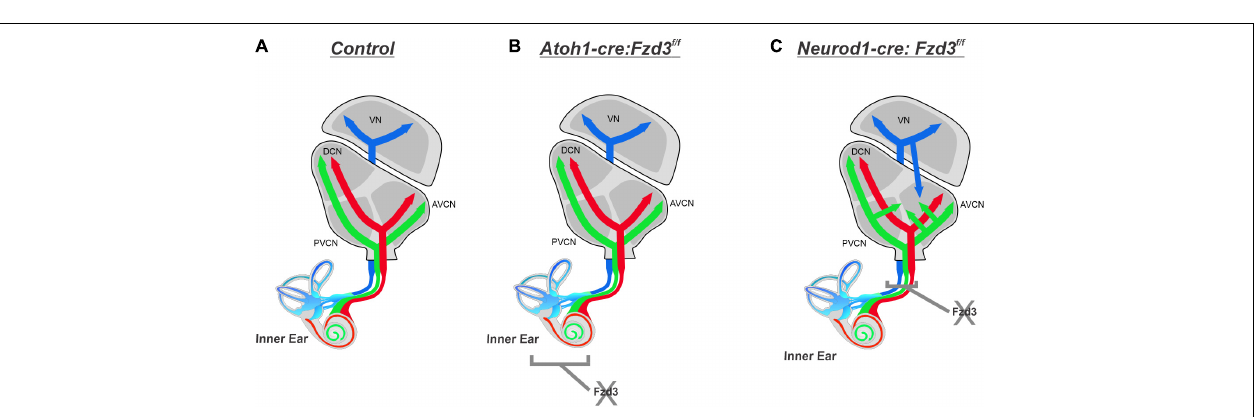
FIGURE 4 | Vestibular afferents project out of the VN following the loss of Fzd3 . Lipophilic dyes were applied to the apex (projection boundary outlined by dotted yellow line) and the utricle/anterior crista (cyan) of control (A,D) , Atoh1-cre:Fzd3 f / f (B,E) , and Neurod1-cre:Fzd3 f / f mutant (C,F) cochleae at P0 and their central projections were analyzed (A–F) . In the control, vestibular afferents project toward the VN and remain segregated from cochlear afferents (A) . In the Atoh1-cre:Fzd3 f / f mutant, vestibular afferents also remain segregated from cochlear afferents and send projections toward the VN (B) . In contrast, vestibular afferents in the Neurod1-cre:Fzd3 f / f mutant project out of the VN into the AVCN resulting in a loss of segregation between cochlear and vestibular afferents (C) . Higher magnification of the VN and AVCN (D–F) showing the projection of vestibular and apical afferents in the control (D) , Atoh1-cre:Fzd3 f / f (E) and Neurod1-cre:Fzd3 f / f mutant (D) . The white arrows show the projection of a single vestibular afferent out of the VN, into the AVCN of the Neurod1-cre:Fzd3 f / f mutant (C,F) . AC, anterior cristae; VN, vestibular nucleus; AVCN, anteroventral cochlear nucleus; DCN, dorsal cochlear nucleus; PVCN, posteroventral cochlear nucleus; A, anterior; D, dorsal. Orientation for all panels the same as (A) . Scale bars, 100 µ m. Three mutant animals and three littermate controls were analyzed.